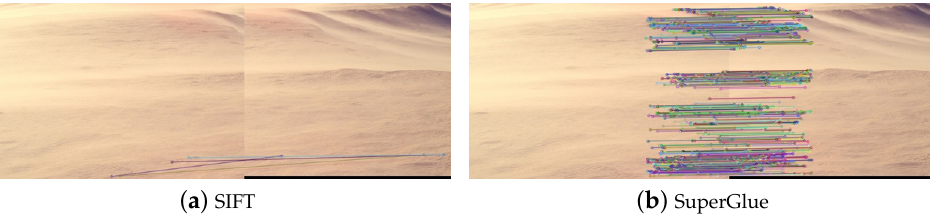
Figure 1. Weak texture image matching case (colored lines represent corresponding matching points).( a ) There is no match point by SIFT method; ( b ) There are many match points by SuperGlue method.